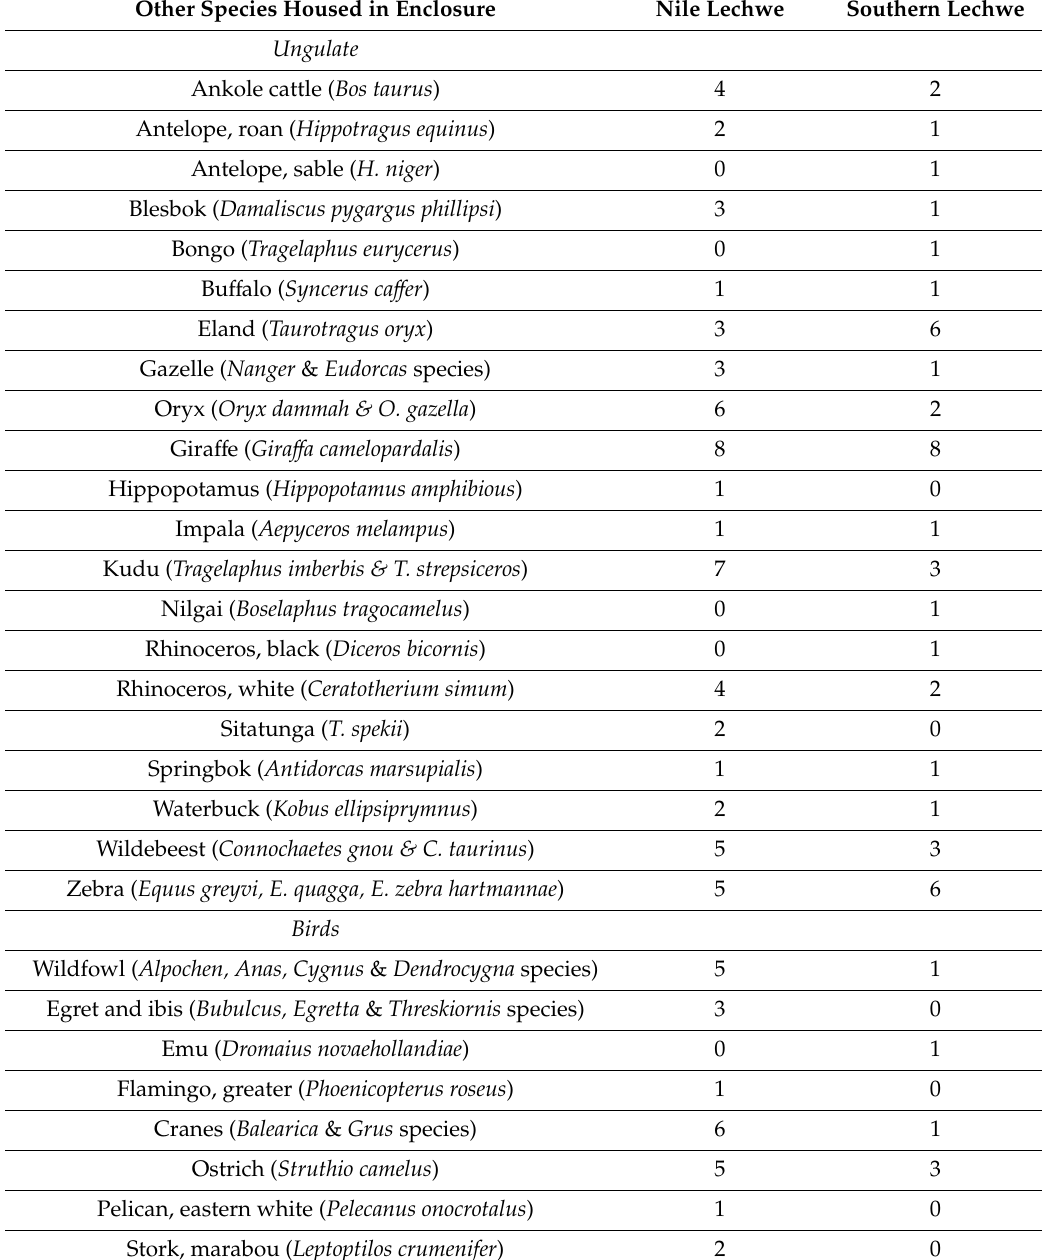
Table A1. Number of combinations of southern and Nile lechwe in MSE with species identified from these sample